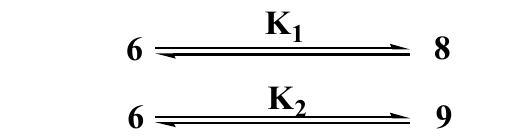
Figure 4. The possible regioisomers of 6 .